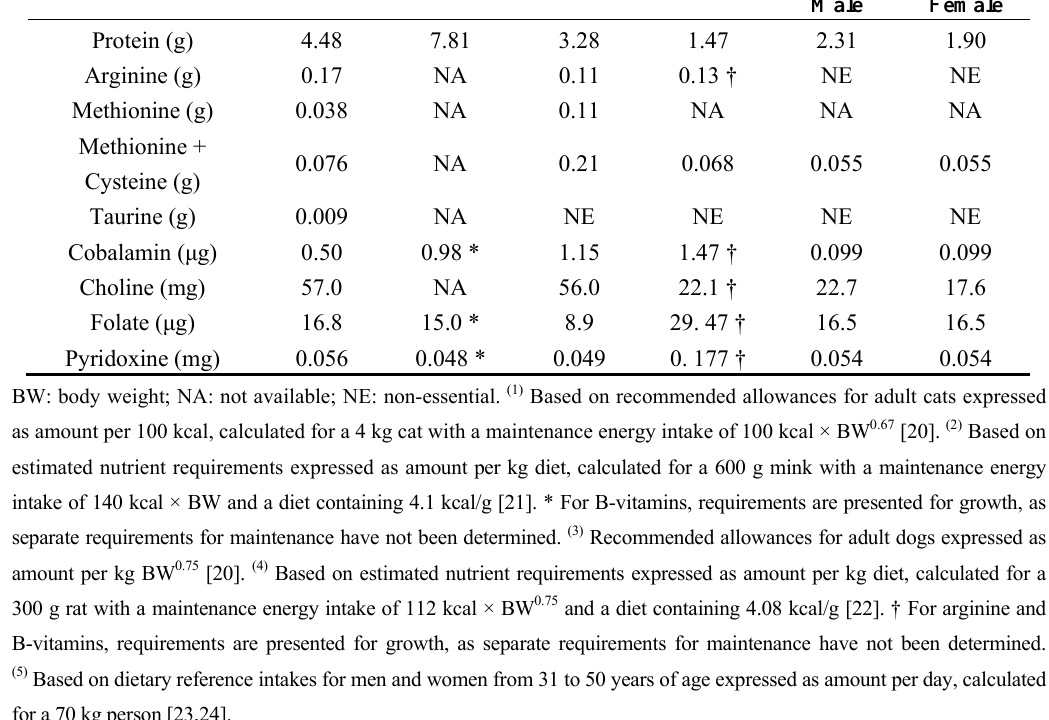
Table 1. Dietary requirements for protein, selected amino acids and B-vitamins linked to one-carbon metabolism in cats, dogs, mink, laboratory rat and male and female human beings. Amount/kg BW 0.75 Cat (1) Mink (2) Dog (3) Rat (4) Human Being (5) Male Female Protein (g) 4.48 7.81 3.28 1.47 2.31 1.90 Arginine (g) 0.17 NA 0.11 NE Methionine (g)